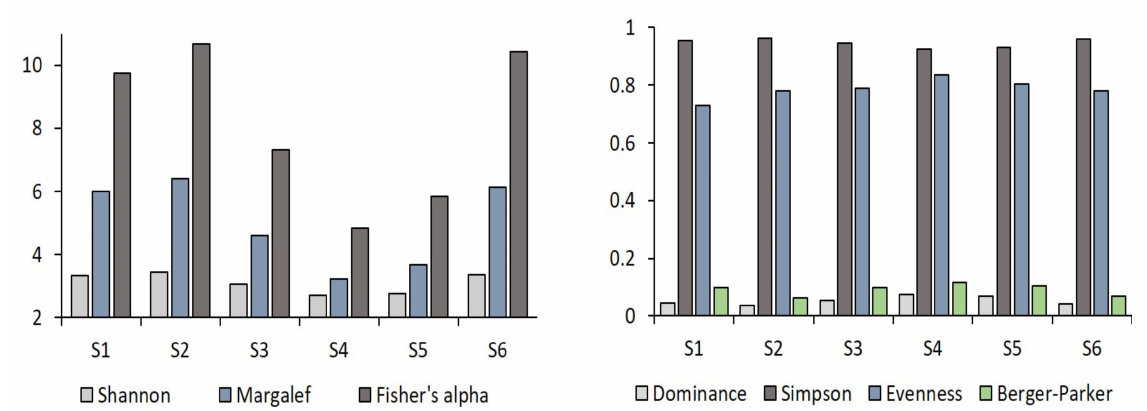
Figure 6. Fish diversity indices at different study locations. ( A ) Shannon, Margalef, and Fisher’s alpha indices, ( B ) dominance, Simpson, evenness, and Berger–Parker